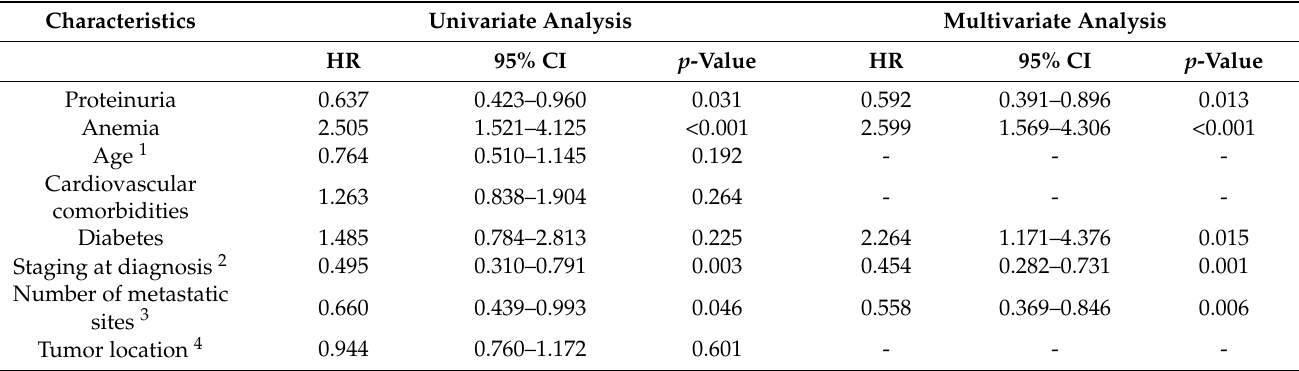
Figure 6. Kaplan–Meier curves of overall survival for matched patients using the propensity score matching method. The patients have or have not developed: ( A ) proteinuria (OS, 40 versus 25 months, p = 0.028), and ( B ) anemia (OS, 31 versus 54 months, p < 0.001) during treatment. ( C ) The patients have or have not obtained a tumor response (OS, 40 versus 23 months, p < 0.001, PD—progressive disease, CR—complete response, PR—Partial response, SD-stabile disease). ( D ) The patients had or had no metastases at the stage of diagnosis, DFS = disease-free survival less or more than 12 months (OS, 29 versus 37 versus 50 months, p = 0.006). Table 5. Univariate and multivariate prognostic factors for longer OS in metastatic colorectal patients treated with bevacizumab and chemotherapy after performing propensity score